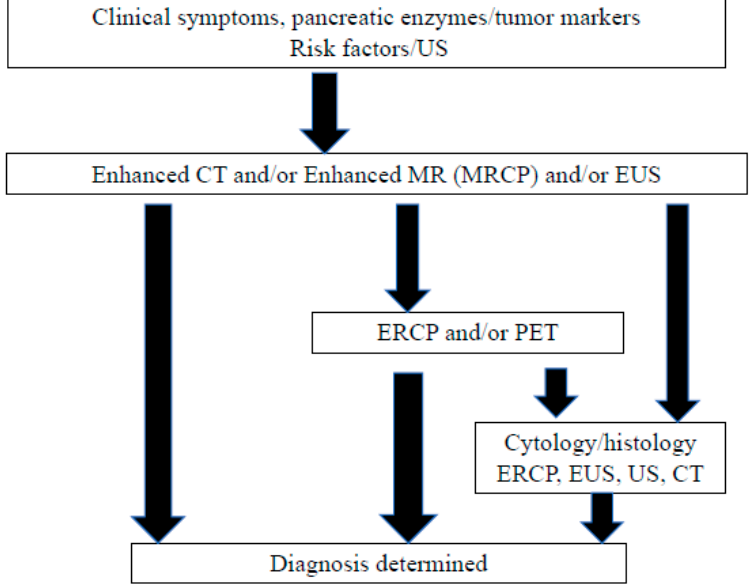
Figure 4. Algorithm of pancreatic cancer diagnosis (adopted from Reference [7]).